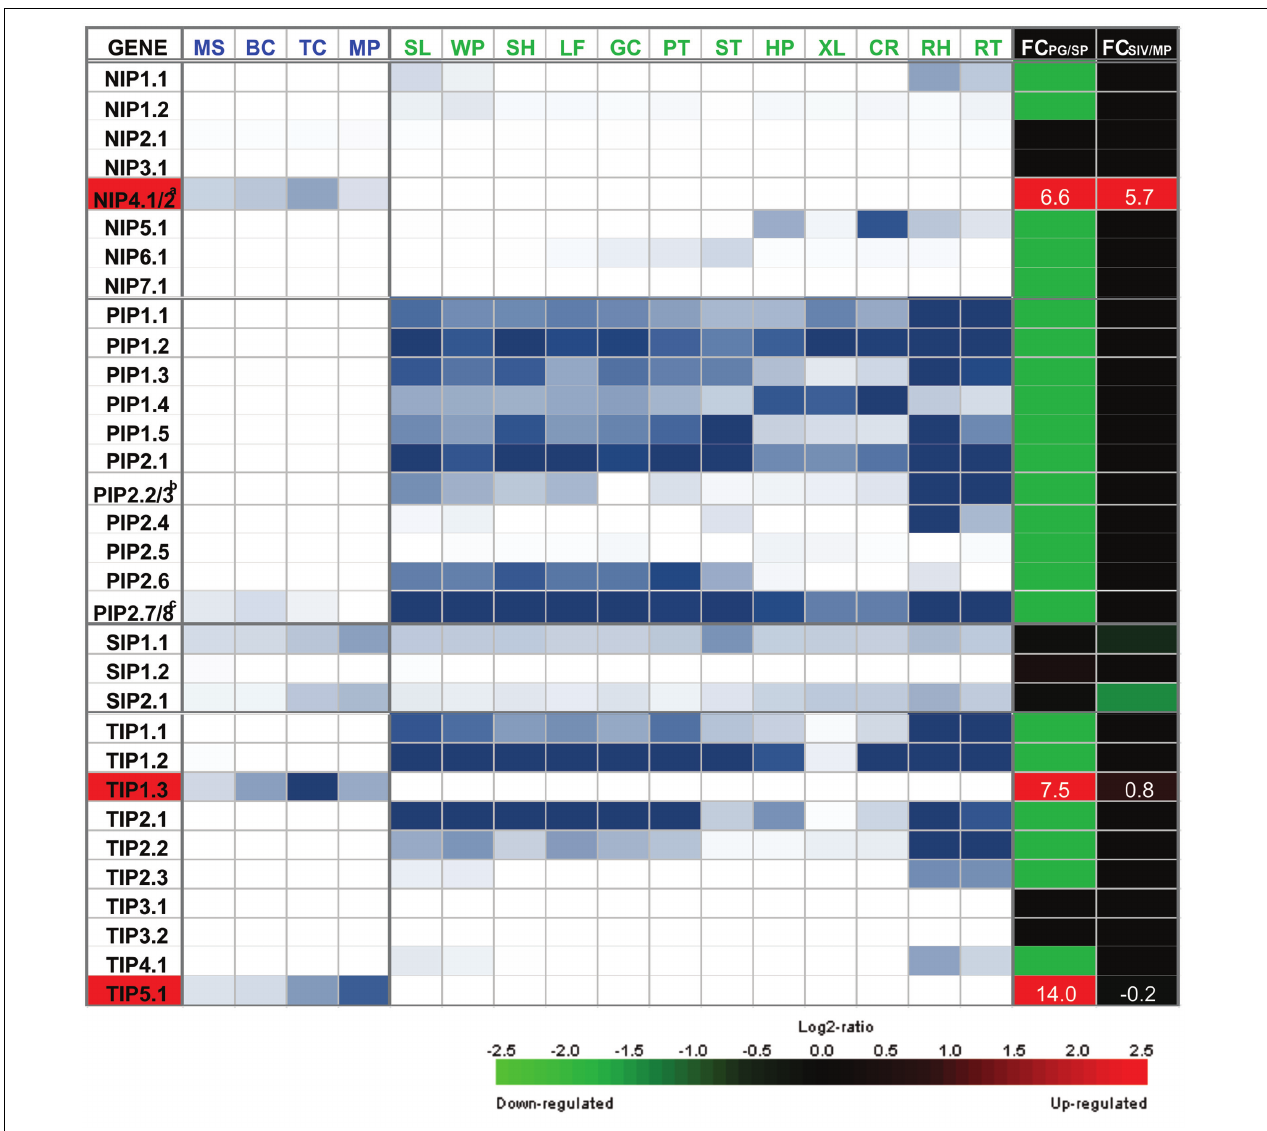
FIGURE 1 | Heatmap representation of the expression of NIP, PIP, SIP, and TIP genes in gametophytic and sporophytic tissues of Arabidopsis . Microarray data for MS, microspore; BC, bicellular pollen; TC, tricellular pollen; and MP, mature pollen; and for sporophytic organ or tissue, SL, seedlings; WP, whole plants; SH, shoots; LF, leave; GC, guard cell-enriched leaf extracts; PT, petioles; ST, stems; HP, hypocotyls; XL, xylem; CR, cork; RH, root hair zone; RT, roots, was obtained from Bock et al. (2006). Scale: white, 10th percentile, blue, 19th percentile. To identify AQP genes that show specific or preferential expression in pollen, fold change (FC) of the maximum expression from the four pollen grain stages (PG) and the maximum expression from the 12 sporophytic tissues (SP) was calculated as the log2 of the ratio of PG/SP. Microarray data for SIV, pollen tubes grown semi in vivo ; and MP, mature pollen grains, was obtained from Qin et al. (2009). To identify AQP genes that are differentially expressed upon pollen germination, FC was calculated as the log2 of the ratio of SIV/MP. FC scale: green = − 2.5 (down-regulated genes), black = 0, red = 2.5 (up-regulated genes). FC values for pollen specific AQPs NIP4;1/2, TIP1;3, and TIP5;1 are indicated in white. a NIP4;1 and NIP4;2 are promiscuously detected by the same probe set 249584_s_at. Based on RNA-seq data (Loraine et al., 2013) and qRT-PCR assays (Pérez Di Giorgio et al., 2016), pollen grain expression corresponds to NIP4;1; whereas NIP4;2 is only expressed in pollen tubes. b PIP2;2 and PIP2;3 are promiscuously detected by the same probe set 265444_s_at. Based on RNA-seq data (Loraine et al., 2013) none of them are expressed in mature pollen. c PIP2;7 and PIP2;8 are promiscuously detected by the same probe set 266533_s_ during pollen development at BC stage, but based on RNA-seq data (Loraine et al., 2013), they are not expressed in mature